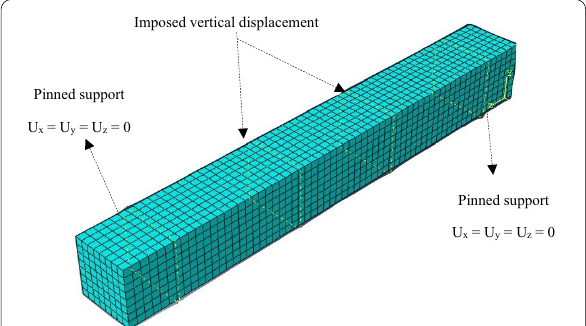
Fig. 23 Mesh configuration and boundary condition.